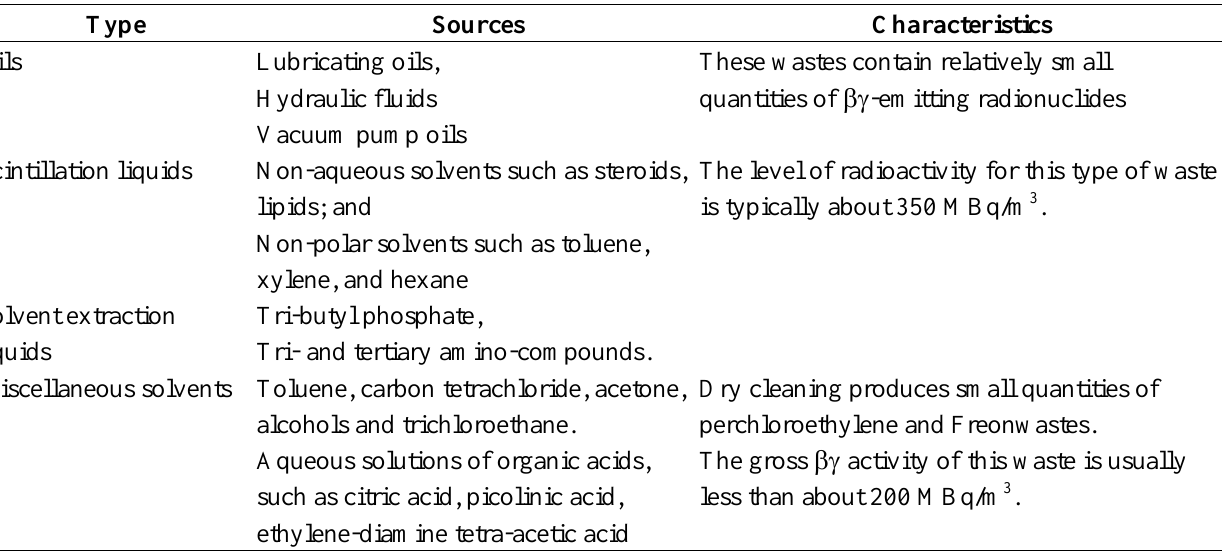
Table 4. Sources of aqueous liquid radioactive wastes [31].